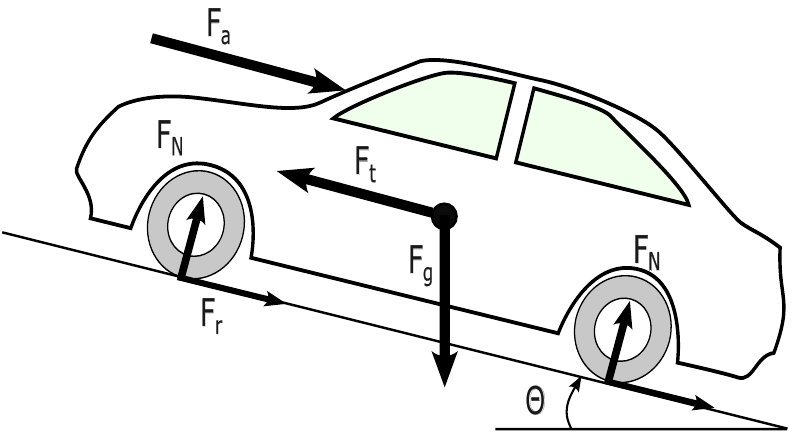
Figure 7. Free body diagram of the